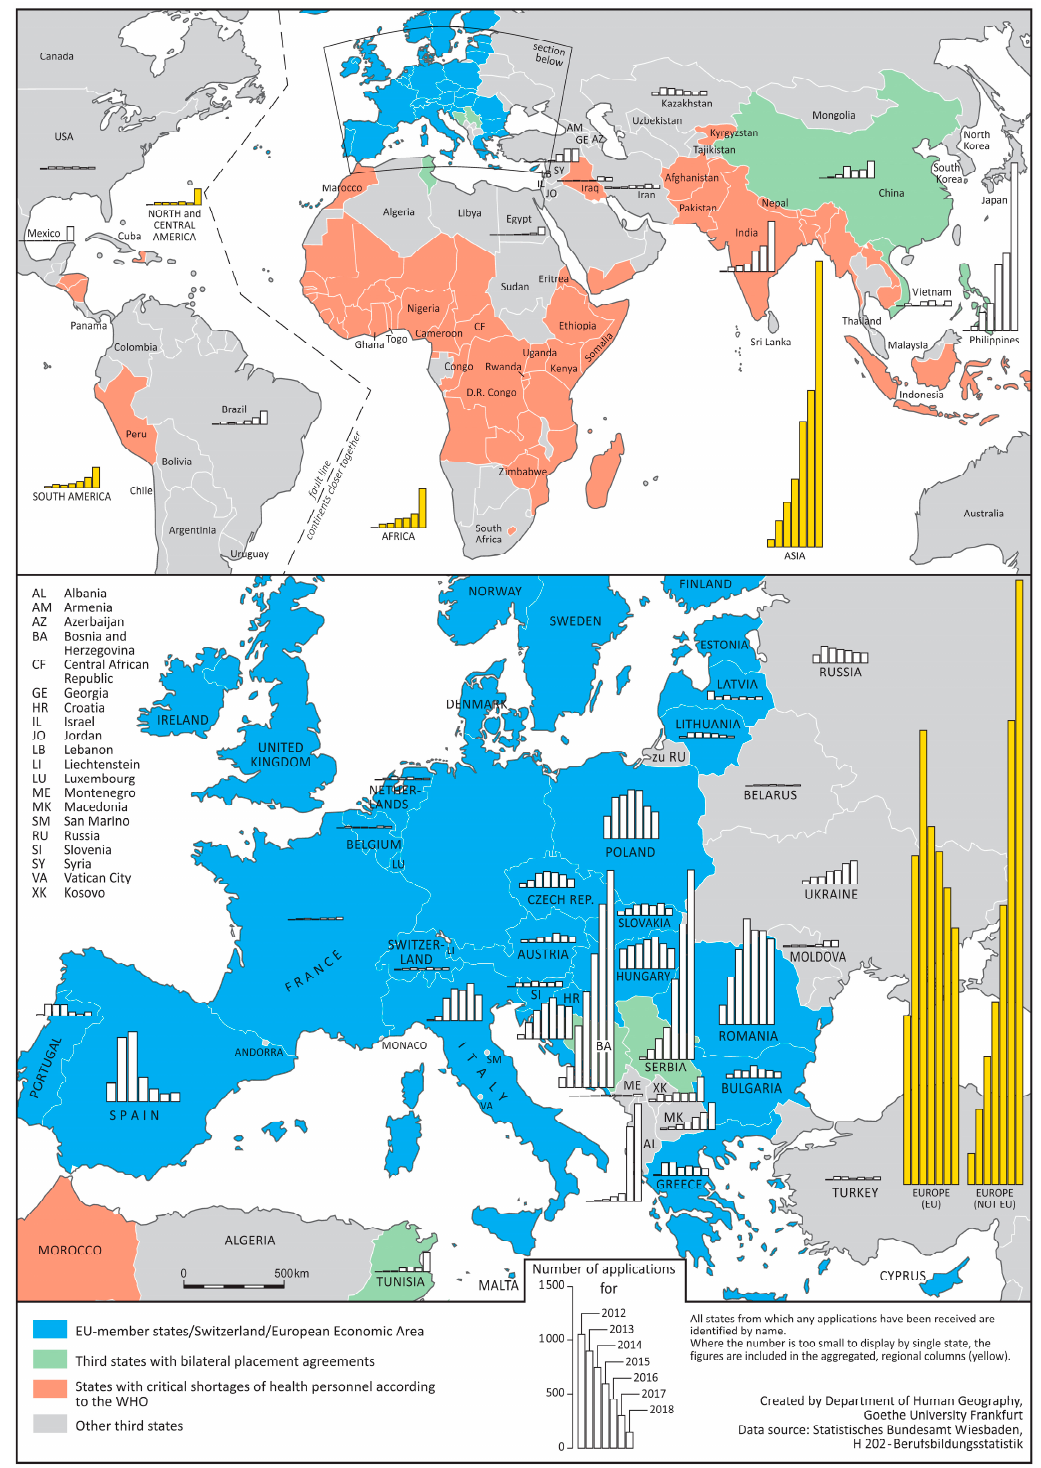
Figure 2. World map displaying the number of new applications for recognition of credentials as registered nurse by distinct regions of origin, as well as individual countries, 2012–2018.